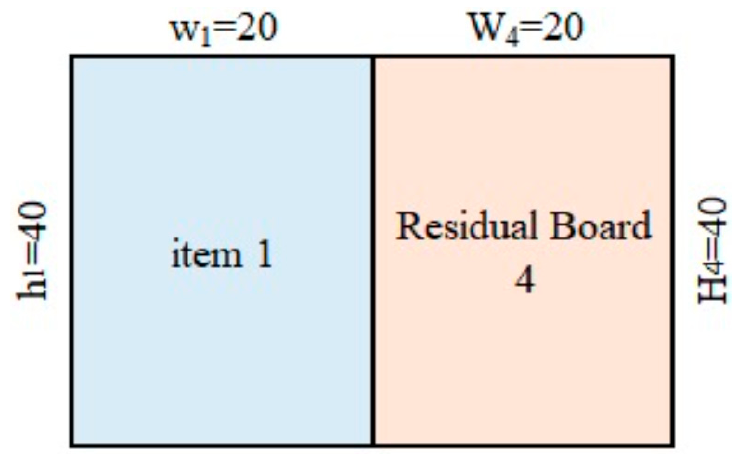
Figure 2. Deduction of item 1 and the residual board 4 of Example 1.